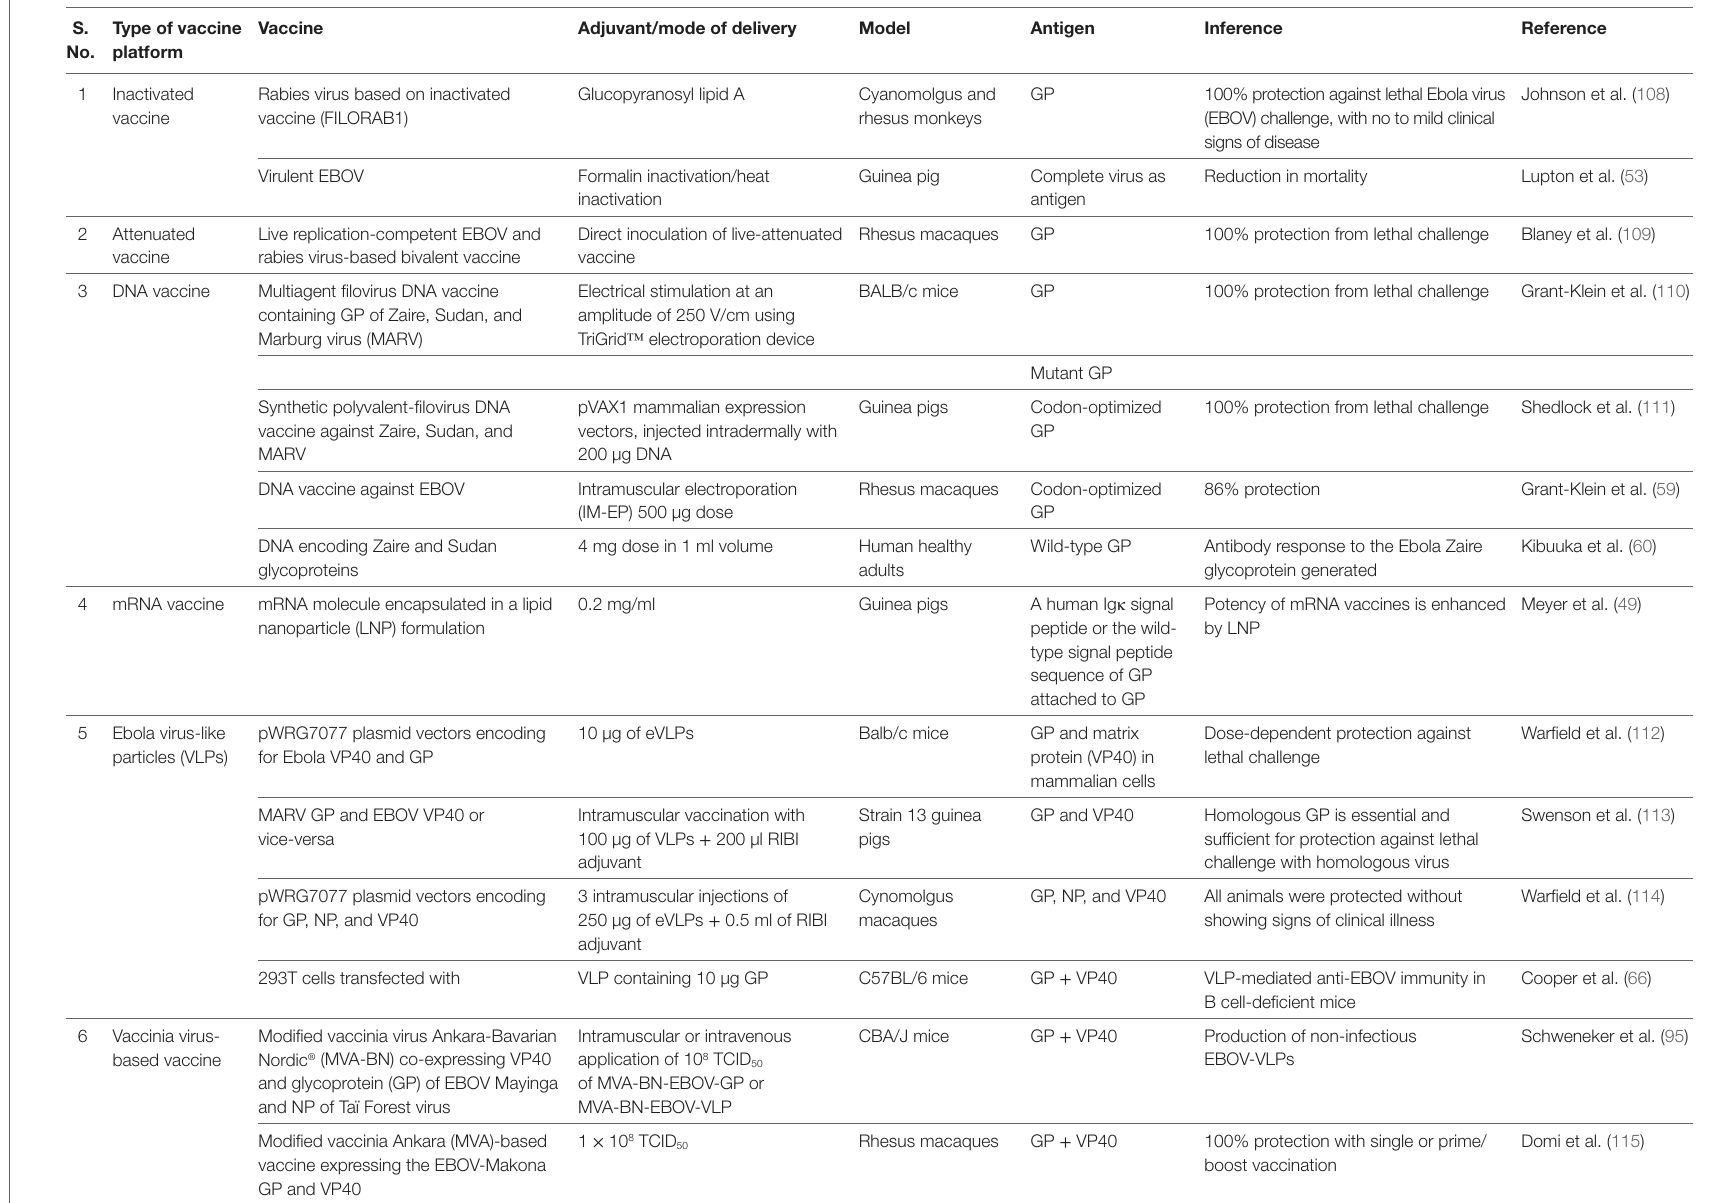
TABLe 1 | Vaccines for treating Ebola virus